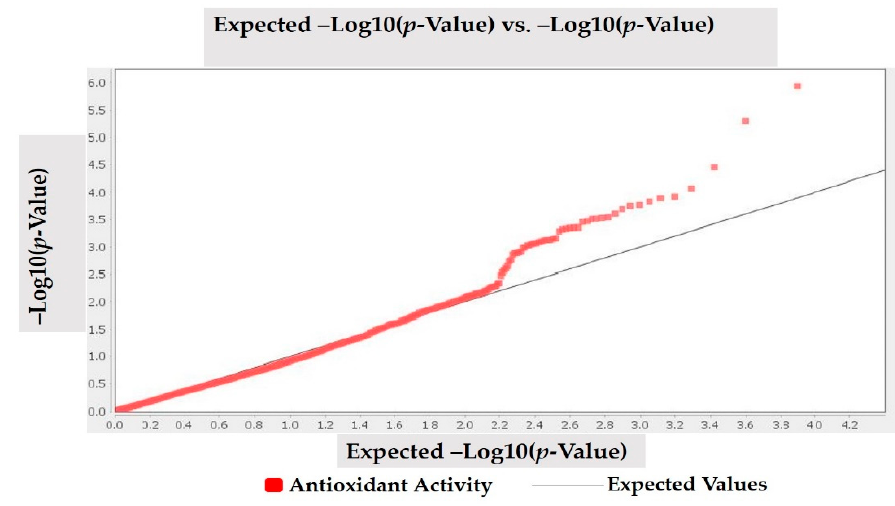
Figure 5. Quantile-quantile (q-q) plots for antioxidant activity in Turkish common bean germplasm.